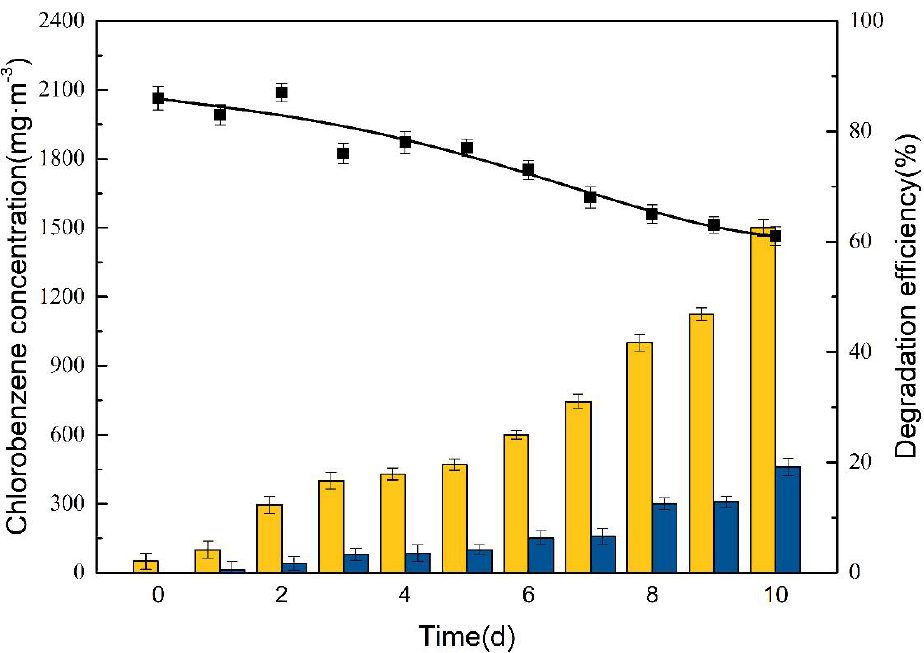
Figure 3. Influence of chlorobenzene concentration on degradation efficiency of BTF ( ■ Degradation efficiency, ■ Inlet concentration, ■ Outlet concentration) (air inlet gas flow = 2000 mL·min −1 , nutrient spray density = 5.17 L·(m −3 ·s −1 ), oxygen concentration = 10%, empty tower dwell time = 48 s, pH = 6.5–7.0).